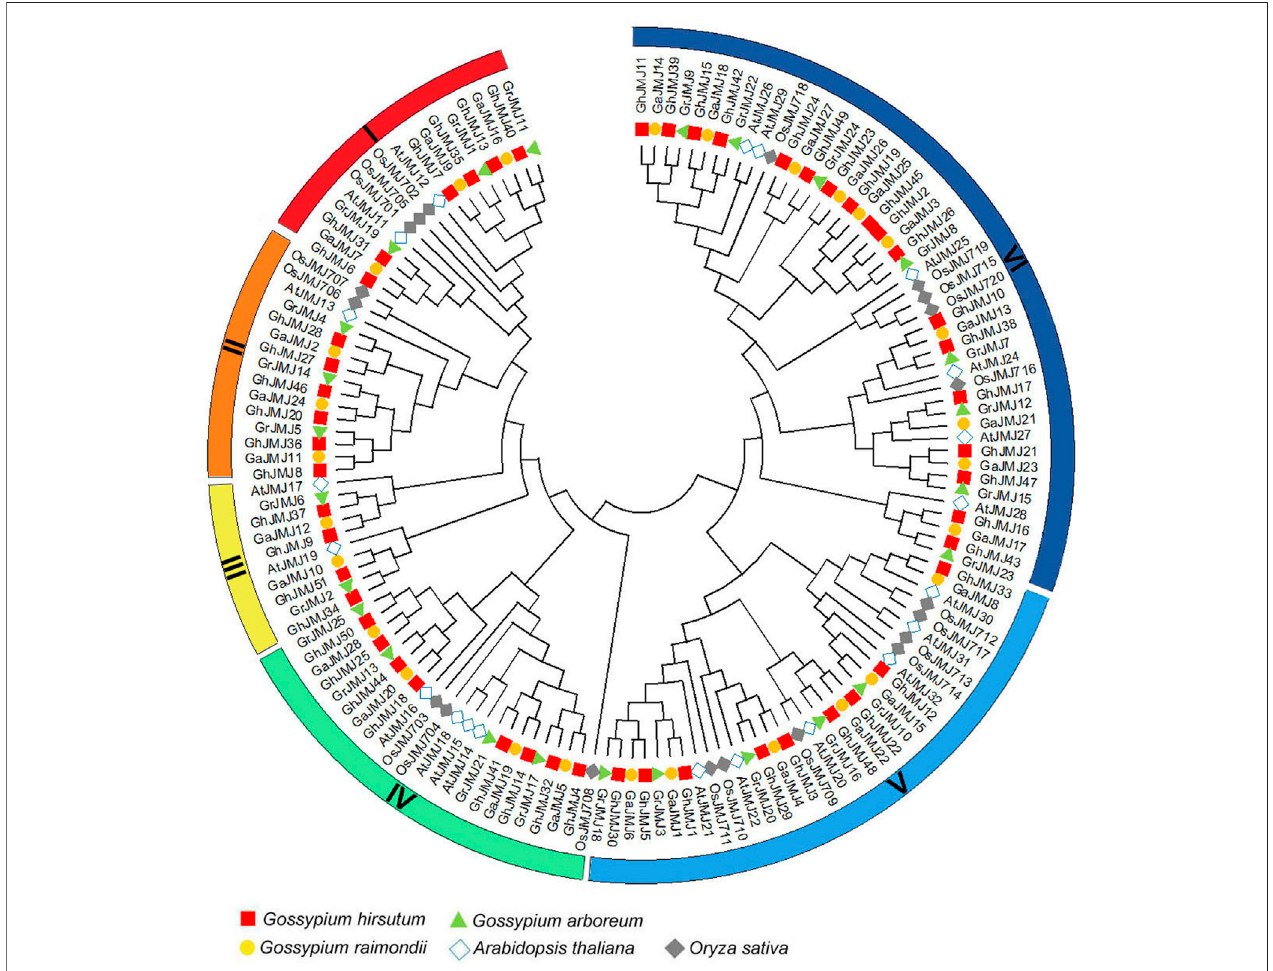
FIGURE1| PhylogeneticrelationshipsofJmjCfamilyproteinsin Gossypiumraimondii (Gr) ,G.arboretum (Ga) ,G.hirsutum (Gh) ,Arabidopsisthaliana (At)and Oryza sativa (Os). The colored arcs indicate different groups of JmjC proteins, and the combination of shape and color indicates different plant species.